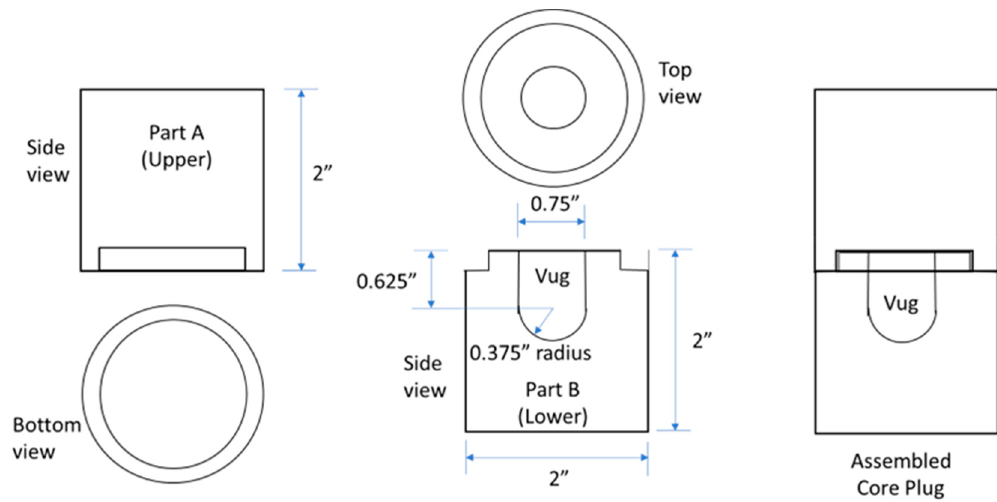
Figure 3. Dimensions of a core plug with artificial vug.